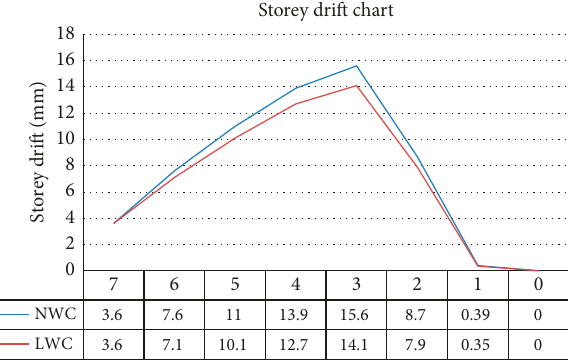
Figure 4: Base shear values of NWC and LWC for each floor.